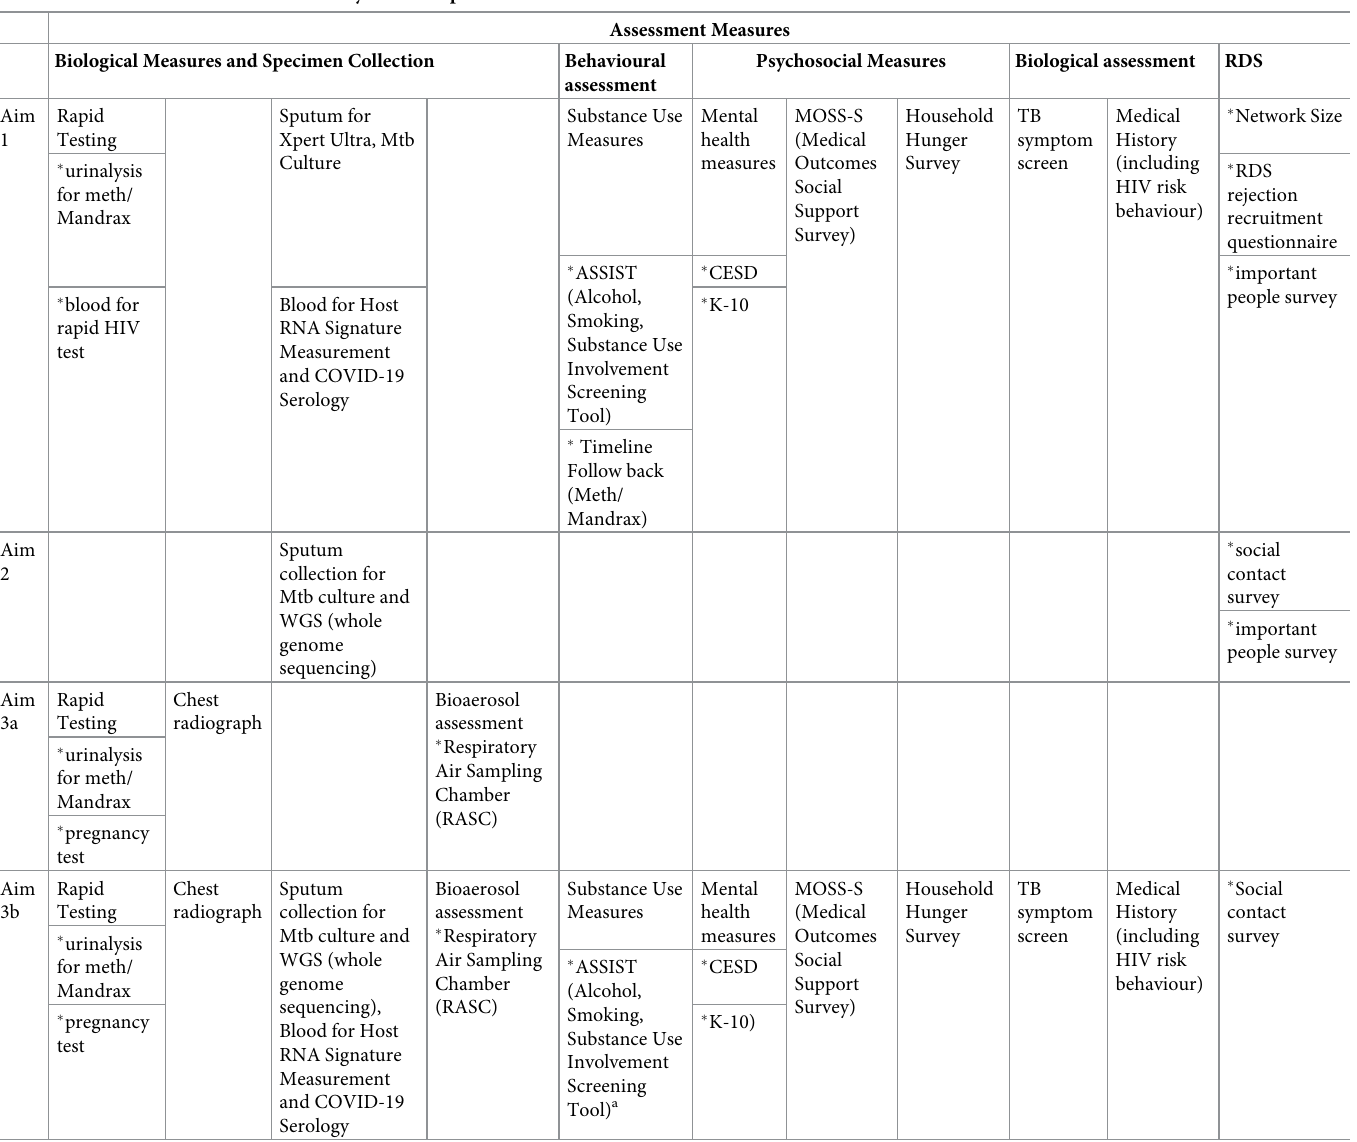
Table 1. Biobehavioral assessments at study visit time